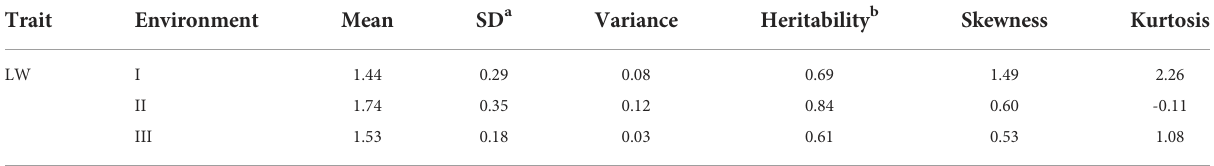
TABLE 1 Variance analysis of the LW values in three environments.